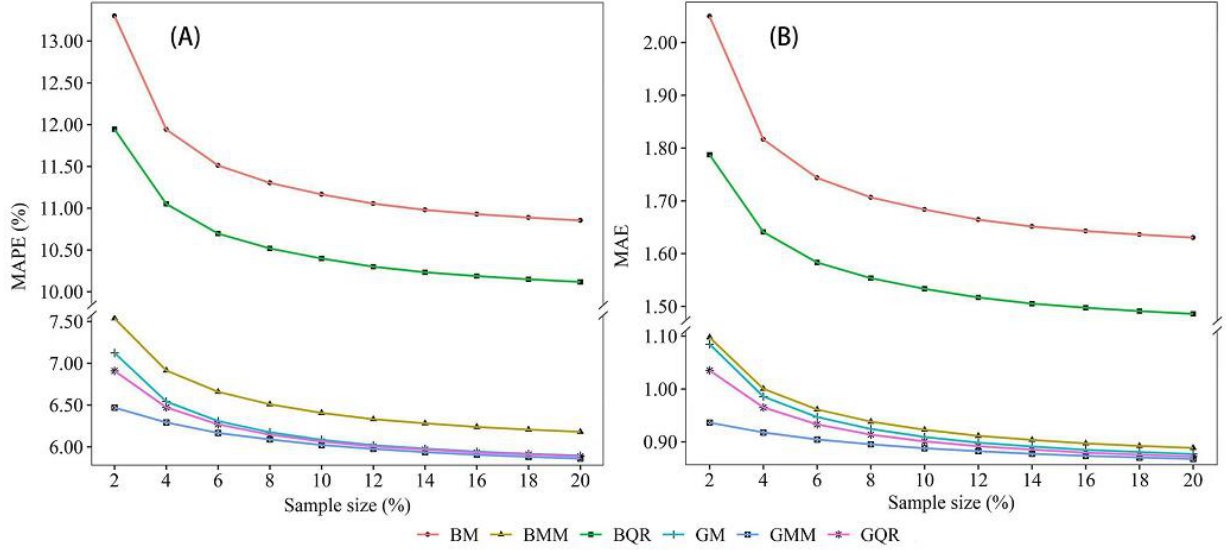
Figure 4. Mean absolute error percentage (MAPE; ( A )) and mean absolute error (MAE; ( B )) for the calibrated BM, BMM, BQR model, GM, GMM and GQR model with different percentages of trees premeasured per plot. Table 6. Statistics of the BM, BMM, BQR model, GM, GMM, and GQR model in different sampling percentages of trees. The numbers in bold indicate the best